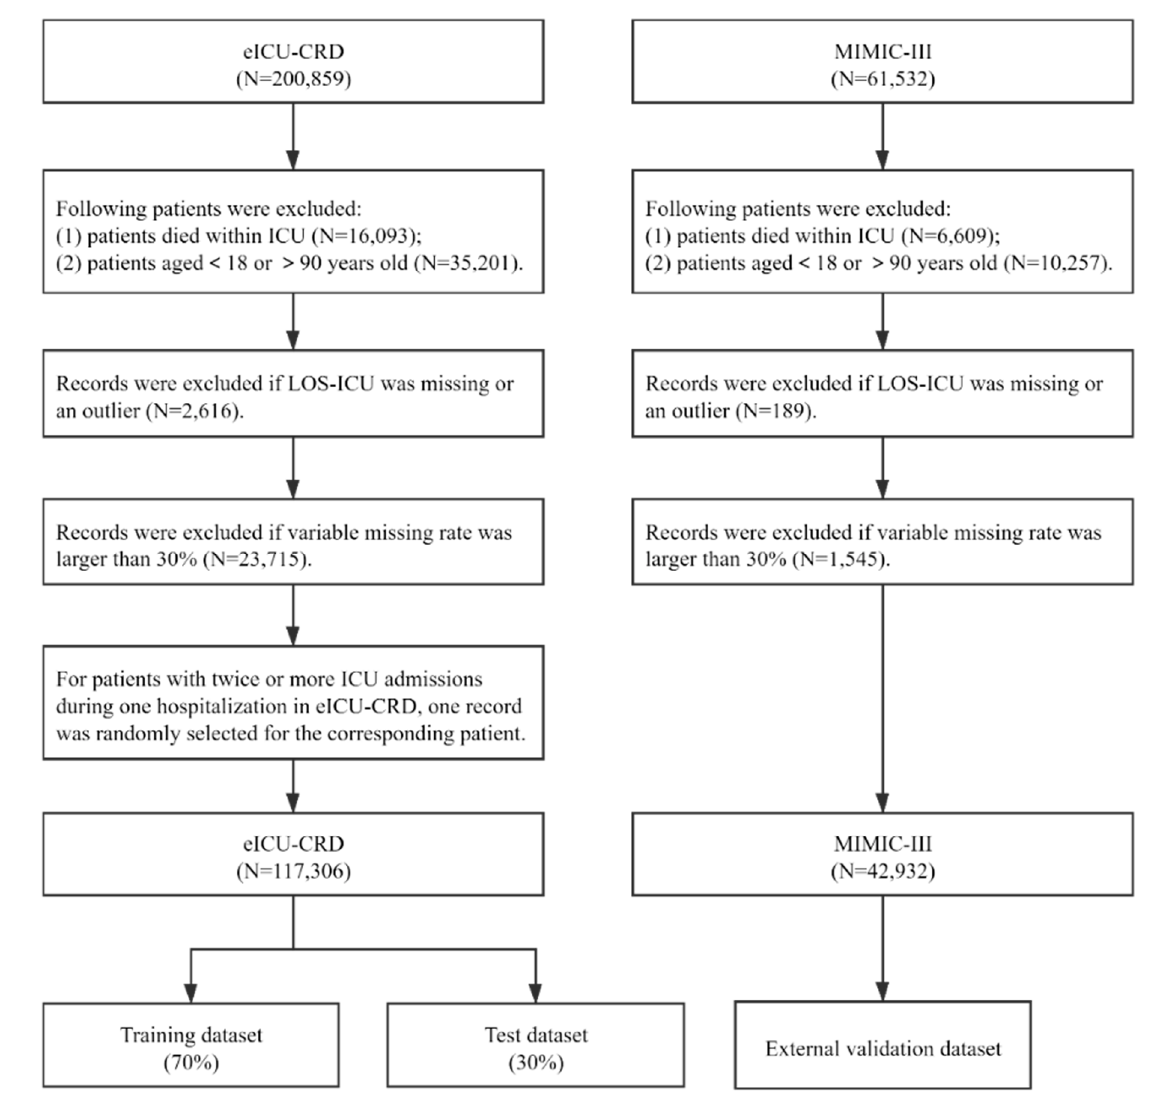
Figure 1. The procedure of study population selection.